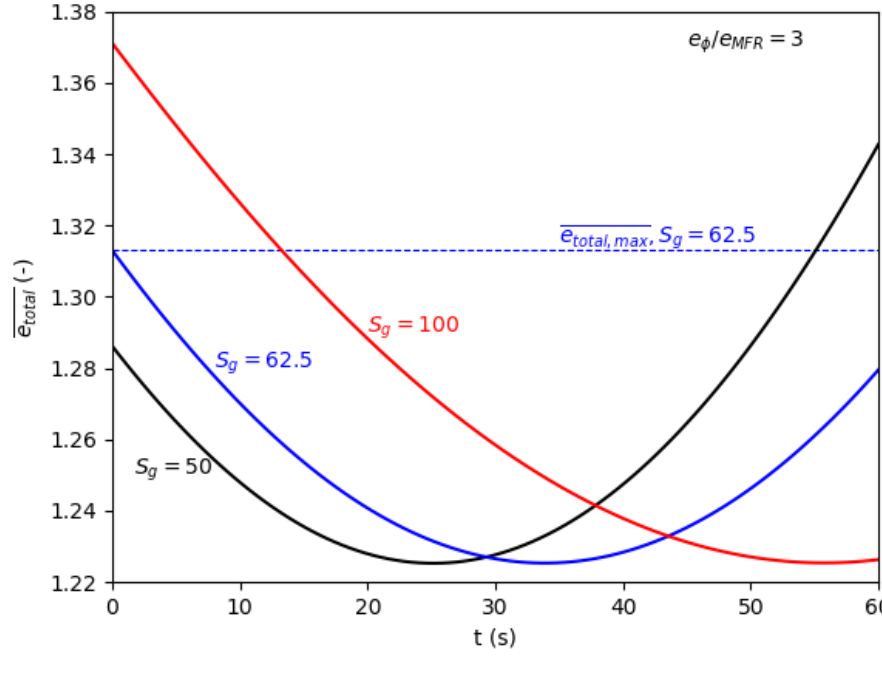
Figure 13. Instantaneous total error